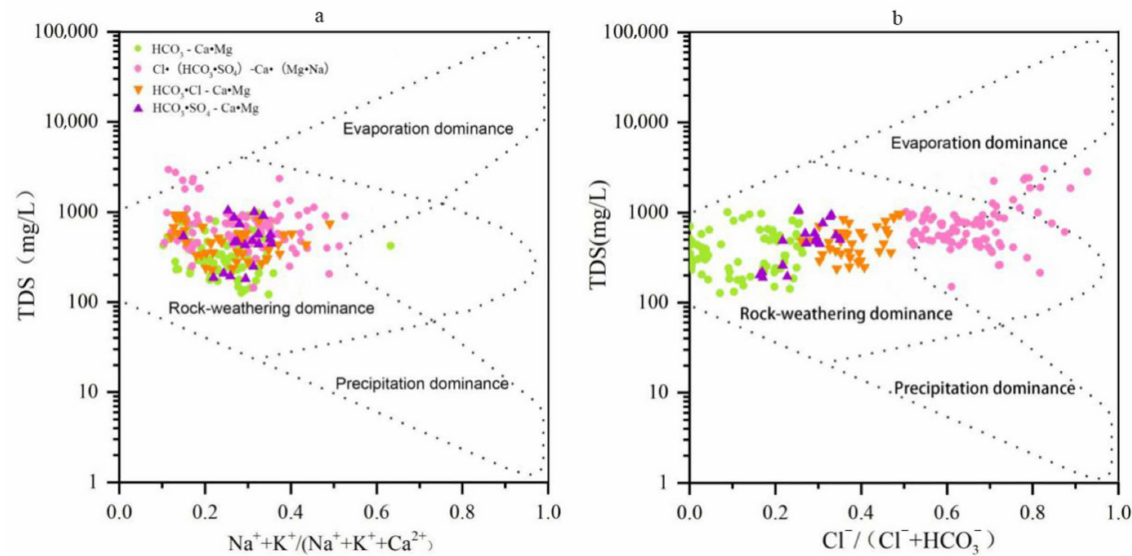
Figure 3. Gibbs diagrams showing the mechanism controlling groundwater chemistry of ( a ) TDS vs. cations and ( b ) TDS vs.